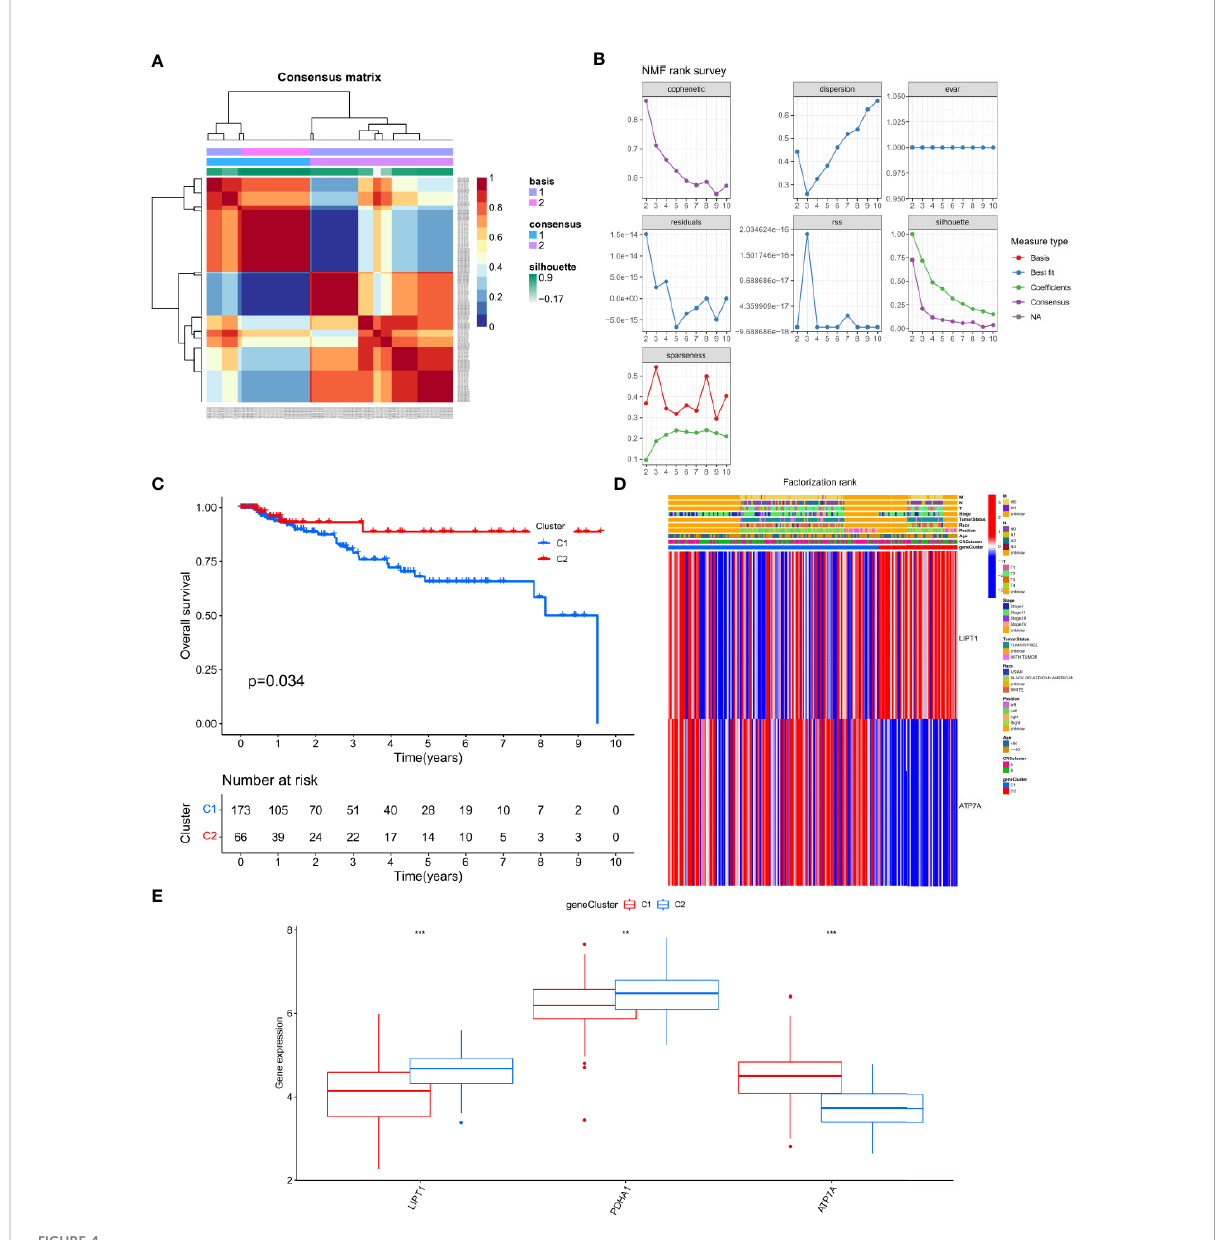
FIGURE 4 Generation and functional annotation of CRGs (A, B) Two subgroups was identi fi ed the optimal value for consensus clustering,and was designated genecluster 1 (C1) and genecluster 2 (C2). (C) Survival curve of the patients between C1 and C2(P = 0.034). (D) Differences in clinicopathologic features and expression levels of CRGs between the C1 and C2. (E) The expression of 3 CRGs between C1 and C2. The asterisks represented the statistical p value (**P < 0.01; ***P <